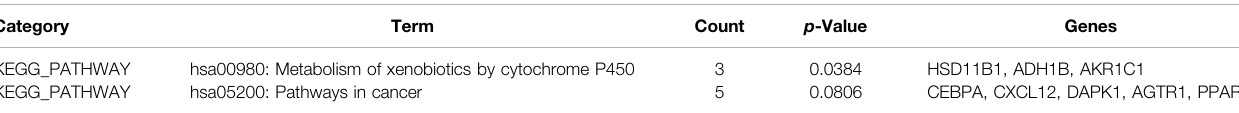
TABLE 3 | KEGG pathways enrichment analyses of downregulated